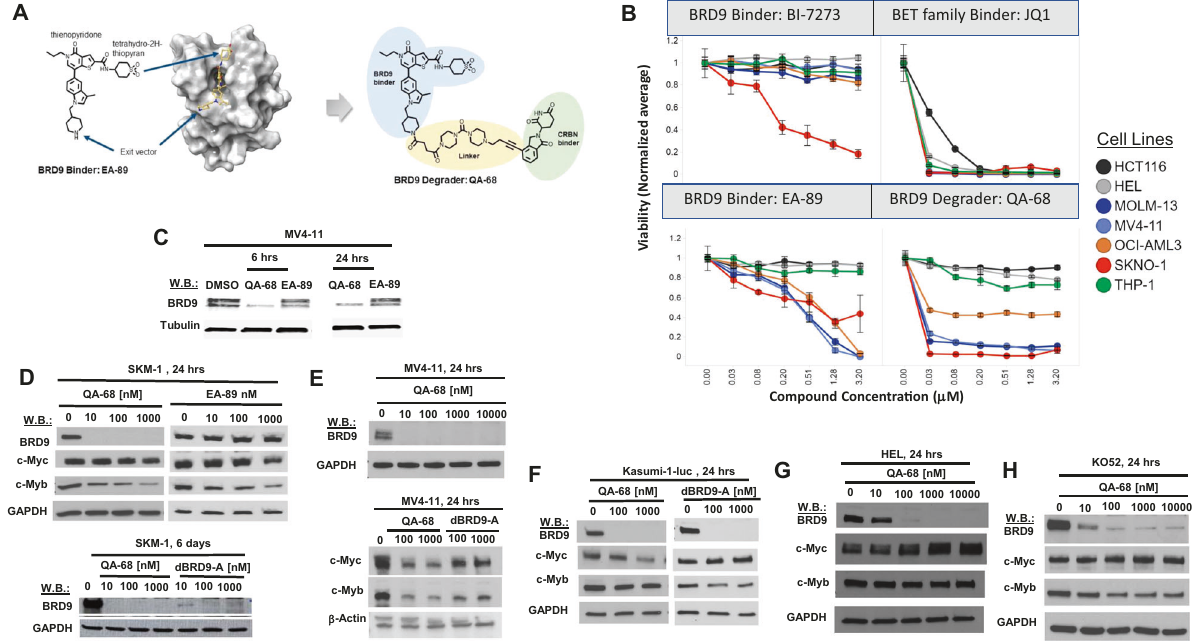
Fig. 1 The BRD9 degrader, QA-68-ZU81, shows increased potency and selectivity versus BRD9 inhibitors. A Structure-based drug design evolves chemical matter from selective binding domain (BD) inhibitor, EA-89-YM35 ( “ EA-89 ” ), to selective BD degrader, QA-68-ZU81 ( “ QA-68 ” ). X-ray co-crystal shows binding mode of EA-89 on BRD9 at 1.76 Angstroms making extended interactions across the surface of BRD9 with thienopyridone docking into the acetyl lysine pocket. B The BRD9 degrader, QA-68, provides an >100-fold increase in potency versus the matched inhibitor, EA-89. 7-day assay. C Effects of BRD9 degrader treatment on BRD9 expression in MV4-11 cells. D , upper panel Comparison of effects of QA-68 and EA-89 on BRD9, c-MYC and c-MYB expression in SKM-1 cells. 24-h assay. D , lower panel Comparison of effects of QA-68 and dBRD9-A on BRD9 expression. 6-day assay. E – H Effects of QA-68 or dBRD9-A treatment on BRD9, c-Myc and c-Myb expression in MV4-11 ( E ), Kasumi-1-luc + ( F ), HEL ( G ) and K052 ( H ). 24-h